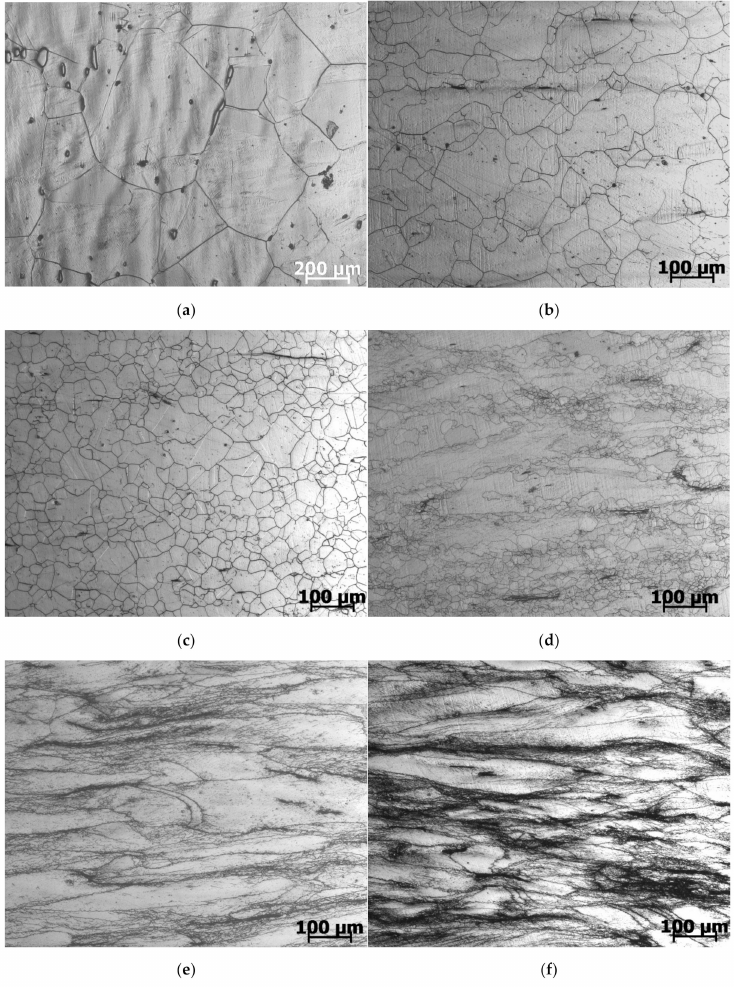
Figure 2. Microstructure of AISI 321 steel after heating to 1280 ◦ C ( a ) and after hot deformation de- formed at different temperatures and strain rates: ( b ) 1200 ◦ C, 0.01 s − 1 ; ( c ) 1200 ◦ C, 1 s − 1 ; ( d ) 1100 ◦ C,